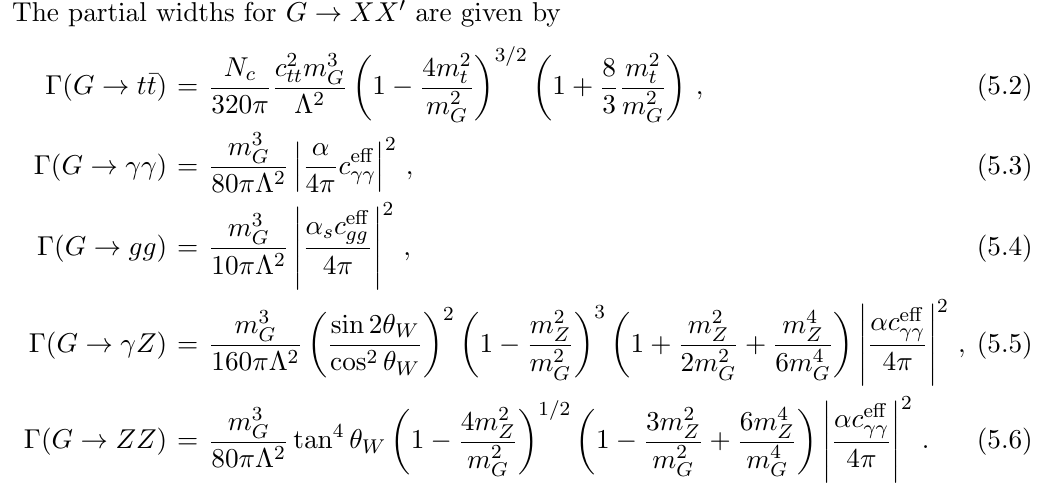
Figure 4 . Production cross sections of the KK graviton with the \LO" accuracy (upper panel), which includes the production via the right-handed top loop at the 13 TeV LHC, and (cid:11) s c e(cid:11) (lower panel) as functions of the KK graviton mass, where (cid:3) = 3 TeV and c tt = 1, along with three choices of c gg = 1 (solid), 0 : 1 (dashed) and 0 : 01